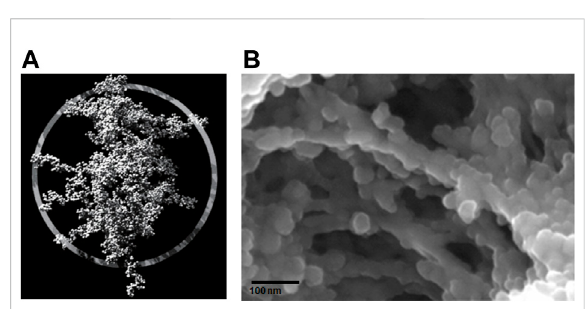
FIGURE 3 (A) Numerically simulated dust aggregate. Reproduced